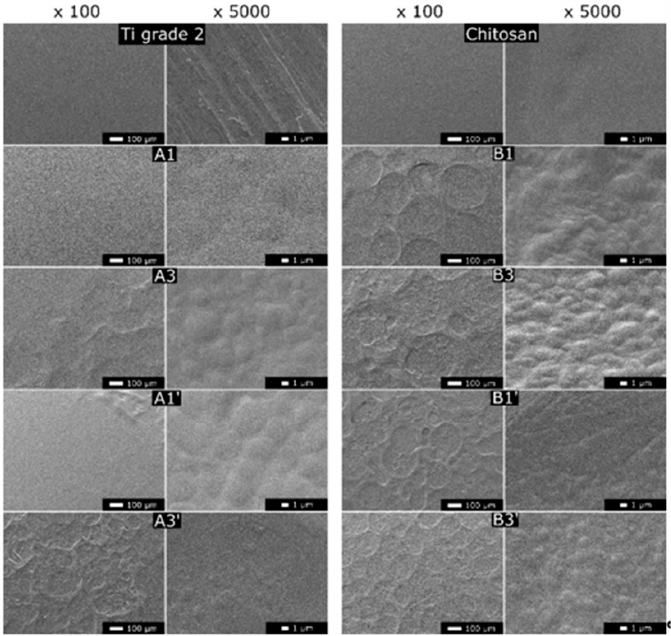
Figure 1. SEM images of the surface topography of the Ti grade 2 substrate, the chitosan coating, and the chit/EE100 coatings obtained at different deposition parameters; the images obtained at different magnifications, ×100 (on the left) and ×5000 (on the right).